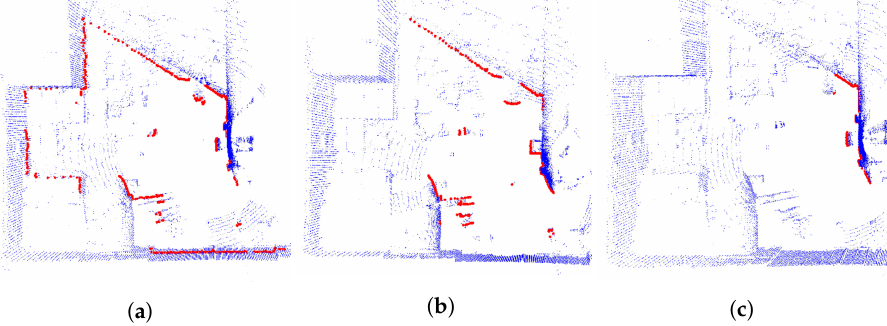
Figure 18. Wall removal. Three-dimensional LIDAR point Cloud (blue), 2D laser scan (red). ( a ) Original 2D laser scan data and 3D LIDAR point cloud. ( b ) Wall segmentation by RANSAC PCL. ( c ) Wall segmentation by limiting 2D laser scan data. Range [0.1, 15] meters, angular field of view [ − 135, 135] degrees.